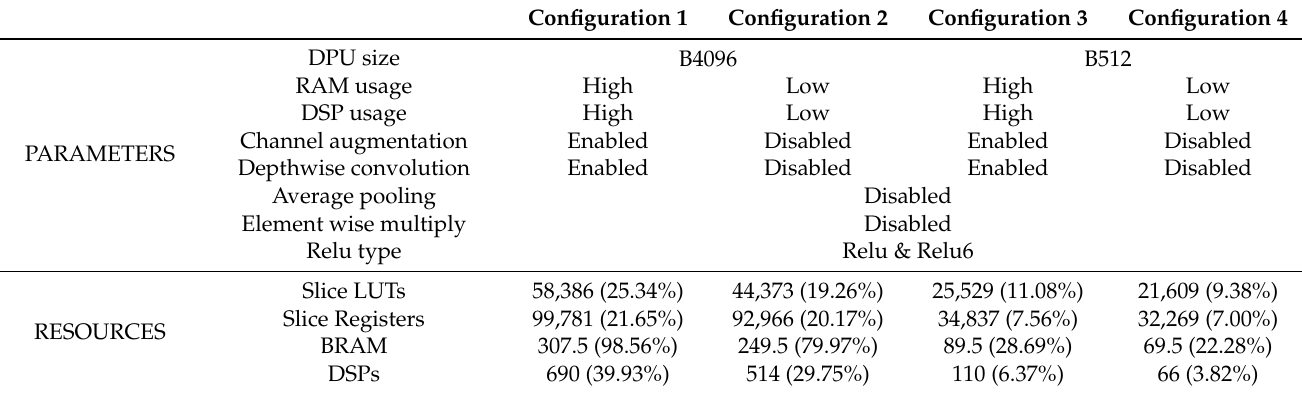
Table 14. The four different configurations of the DPU together with the resource consumption of the configurations.